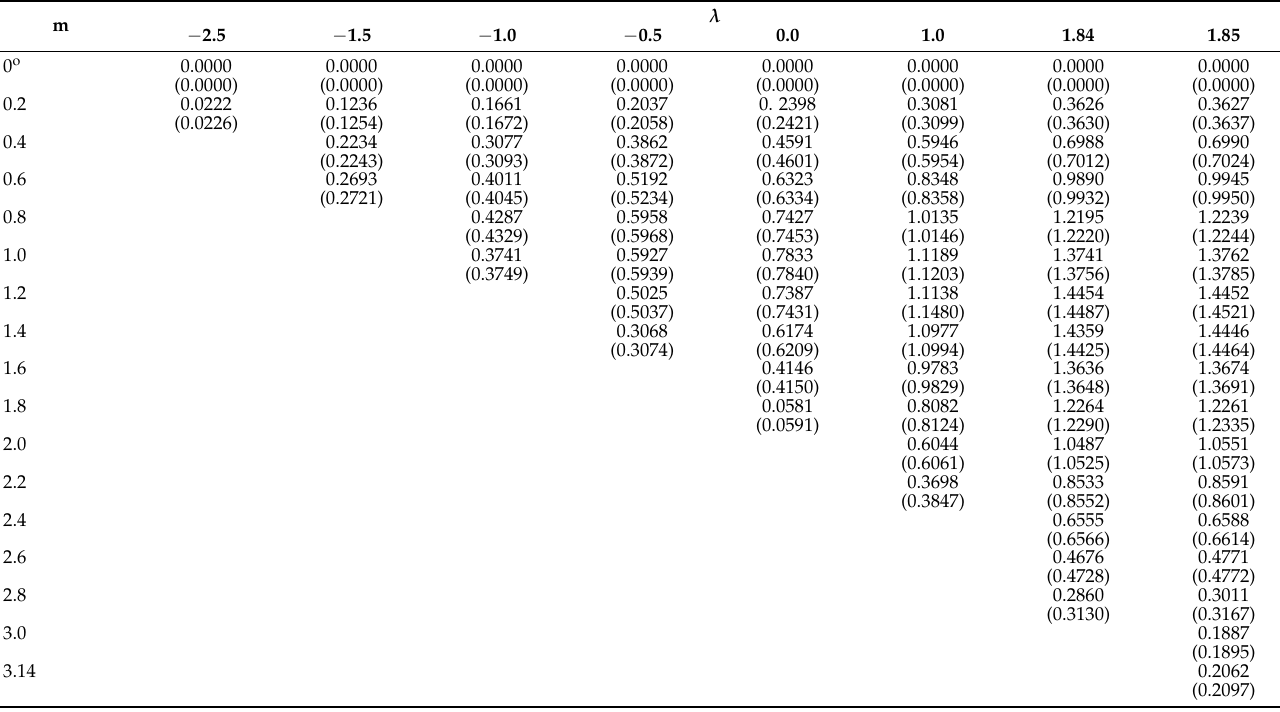
Table 3. The comparison values of C f for χ Ag = χ Oxide = 0, We = 0, M = 0, R = 0, Pr = 6.8, and various values of λ